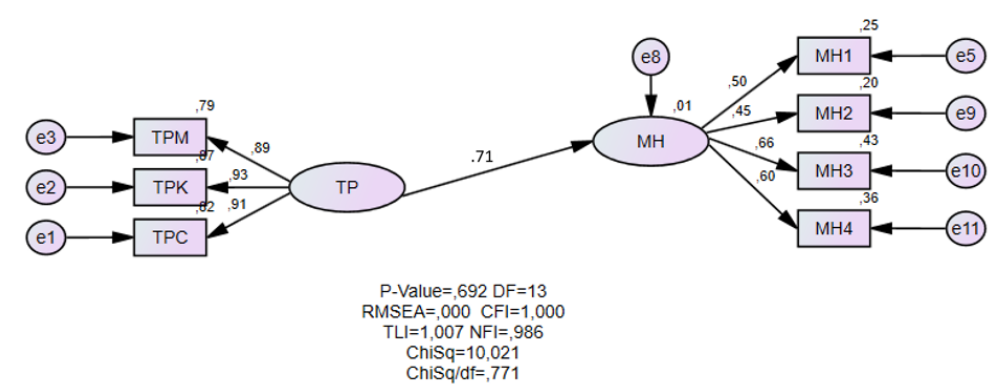
Figure 3: The SEM Analysis of Perceptions and Students Participation.